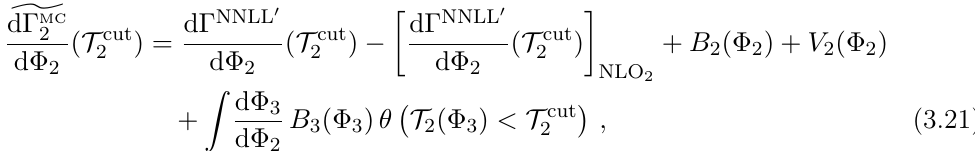
Figure 4. The missing O ( (cid:11) 2 ) nonsingular contribution to the cumulant as a function of T cut s the H ! b (cid:22) b process (left) and the H ! gg (right). The shaded band denotes the statistical error